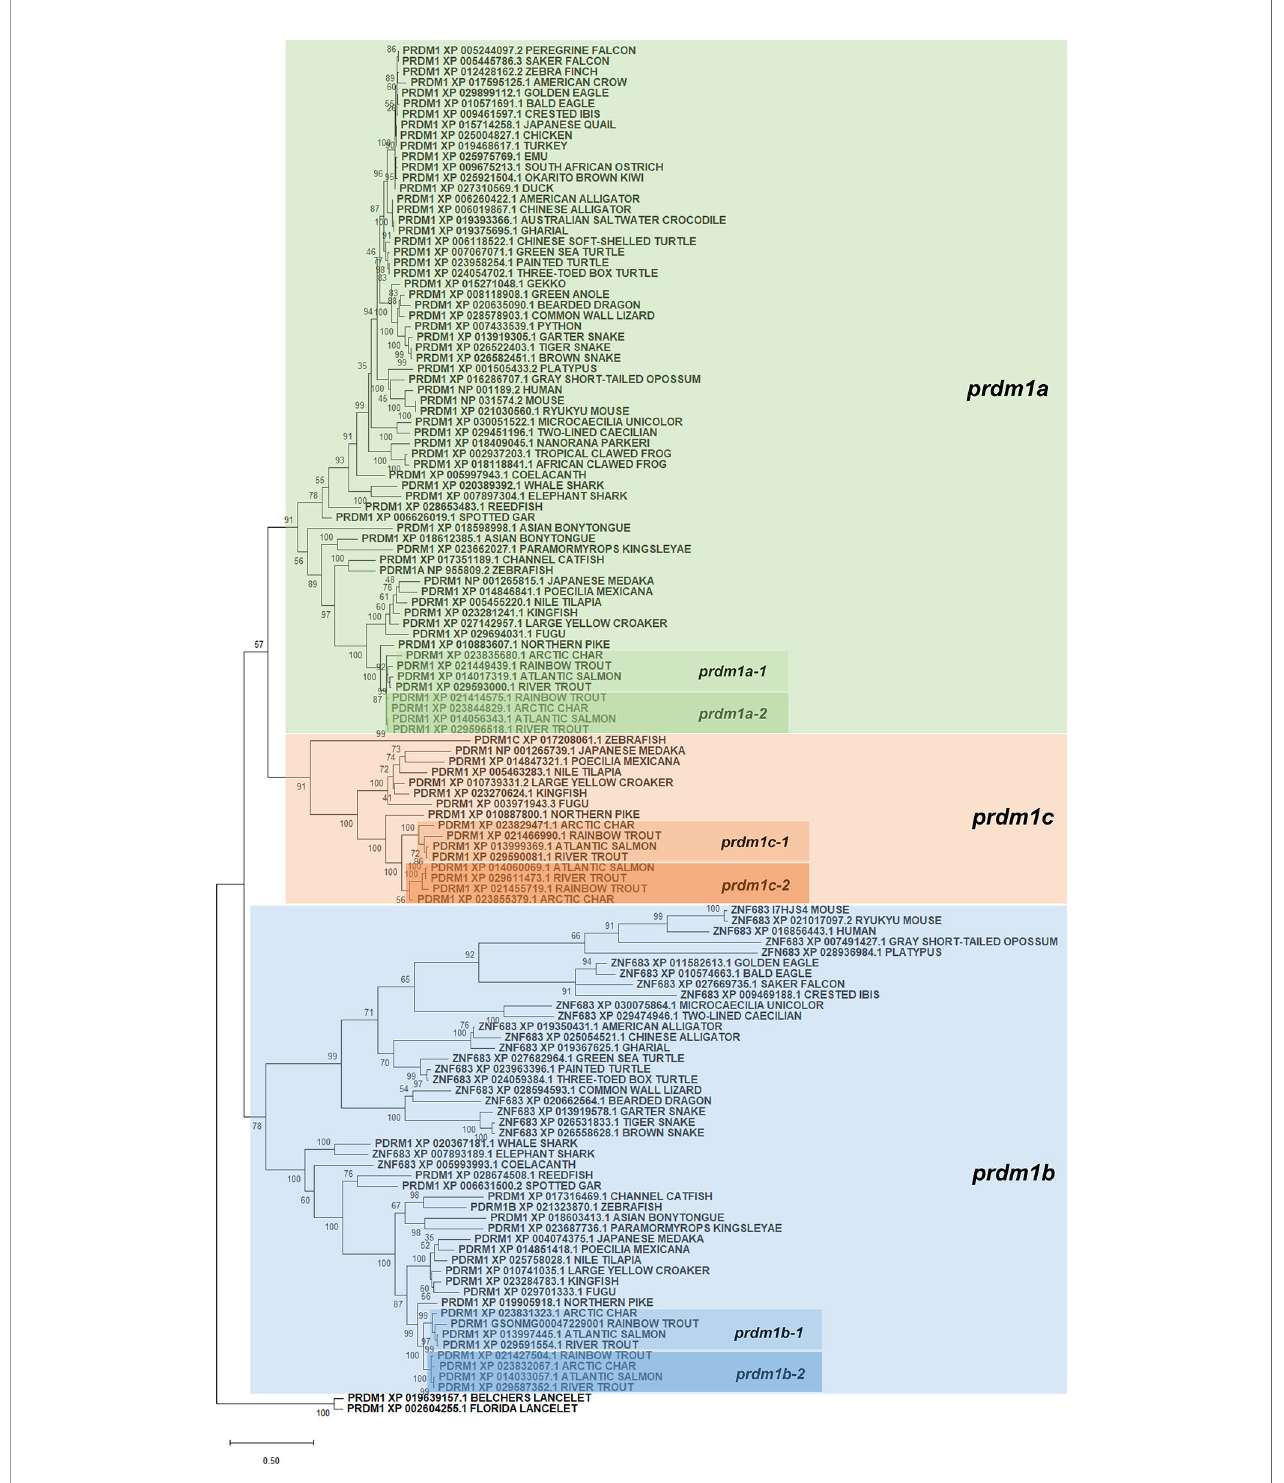
FIGURE 2 | Phylogenetic tree using PRDM1 and ZNF683 proteins from the genomes of several species included in the RefSeq databases. Protein alignment was performed using the ClustalW software and a phylogenetic tree constructed using maximum likelihood analysis. Tree con fi dence was tested using bootstrapping analysis (1,000 replicates). Prdm1 proteins identi fi ed in Branchiostoma belcherii and B. fl oridae were included as outgroup and used for rooting purposes. The tree constructed highlights the three groups of prdm1 genes identi fi ed in fi sh species ( prdm1a , prdm1b , and prdm1c ). Names assigned to different prdm1 genes from salmonids are also included in the phylogenetic